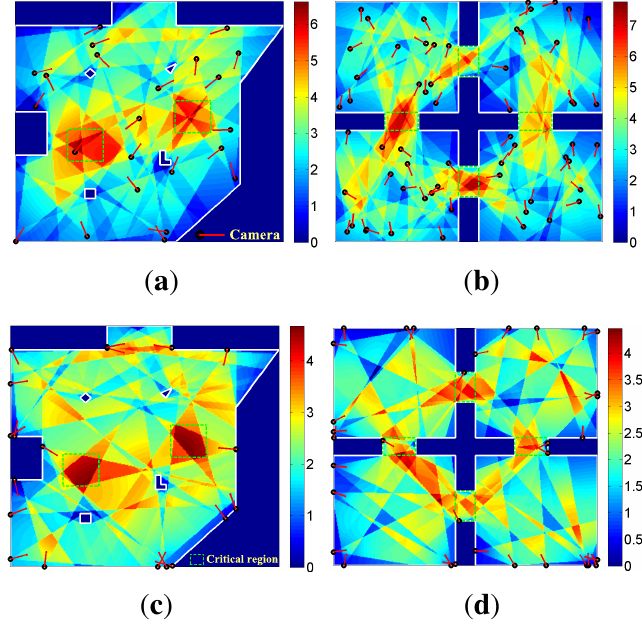
Figure 4. Experimental results of scenes with critical regions. (a) Irregular square scene. (b) Four rooms scene. (c) Boundary restricted layout in irregular square scene. (d) Boundary restricted layout in four rooms